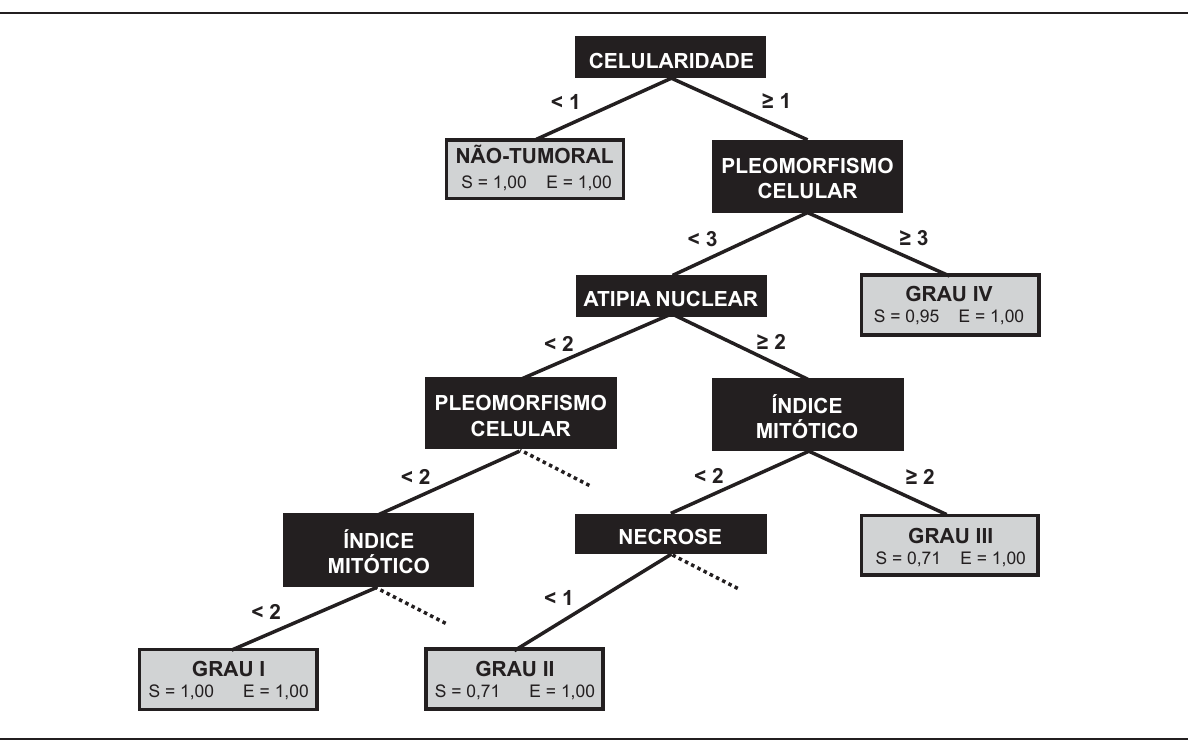
e de atividade mitótica discriminou os tumores grau III. A conjunção de atipia nuclear moderada ou intensa com figuras mitóticas discretas ou ausentes e com a